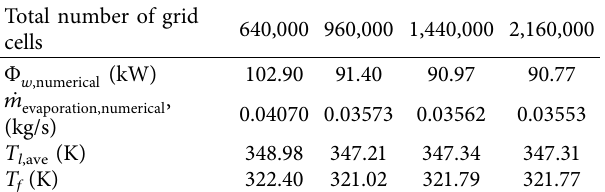
Table 3: Grid independence analysis for the Eulerian_ EWF